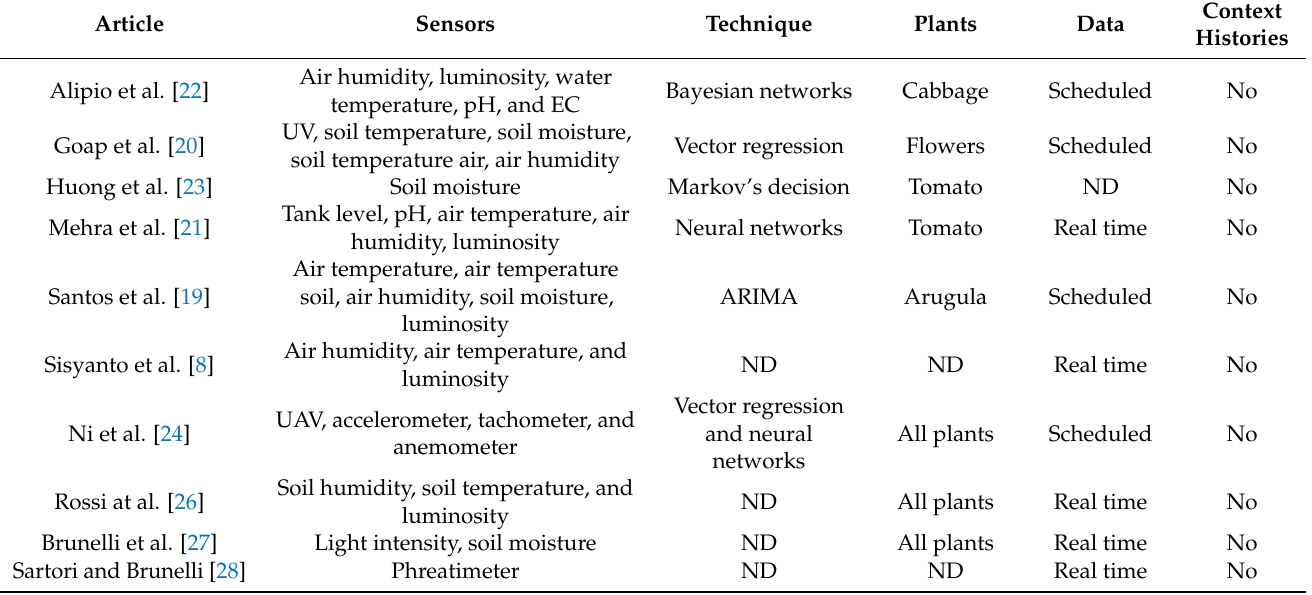
Table 1. Related